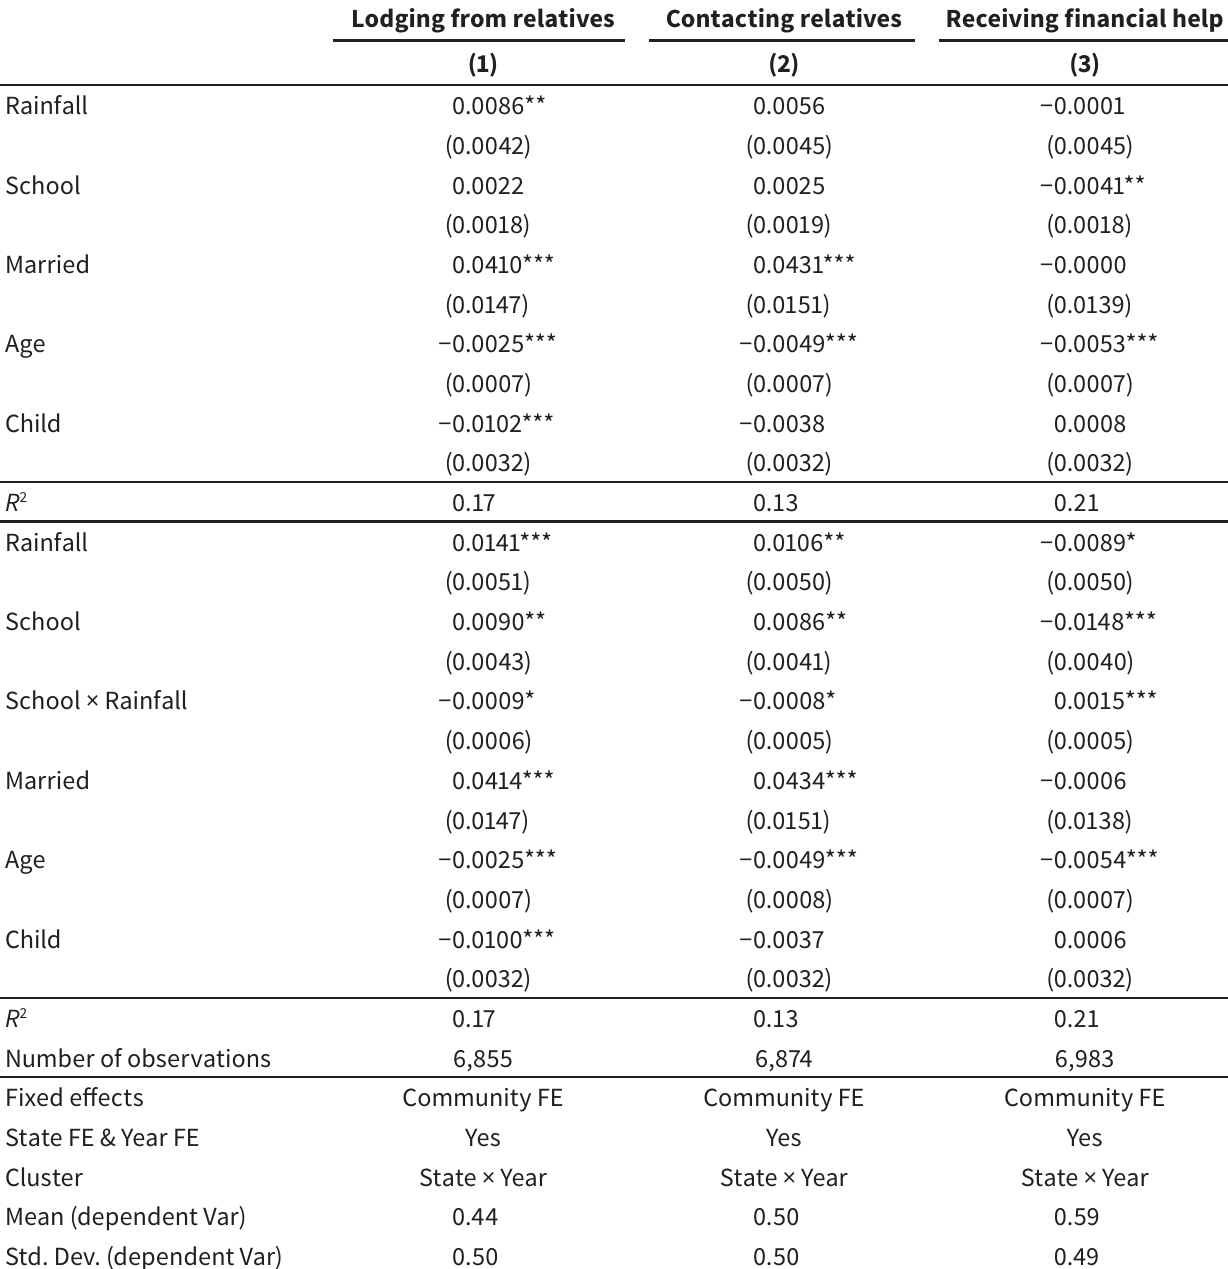
Male migrants’ migration costs (networks) change with